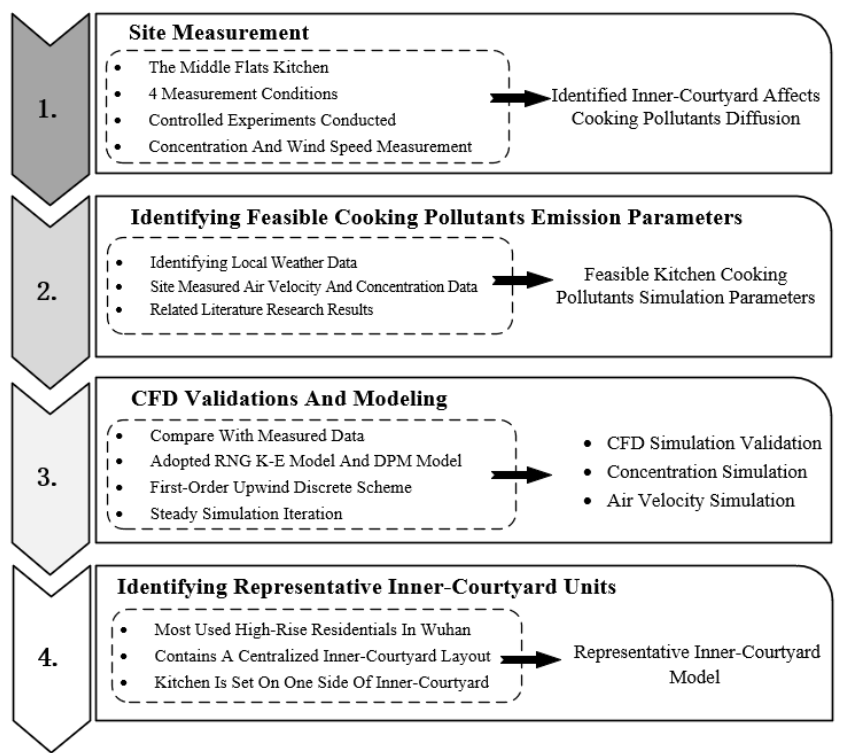
Figure 2. Outline of methodology.